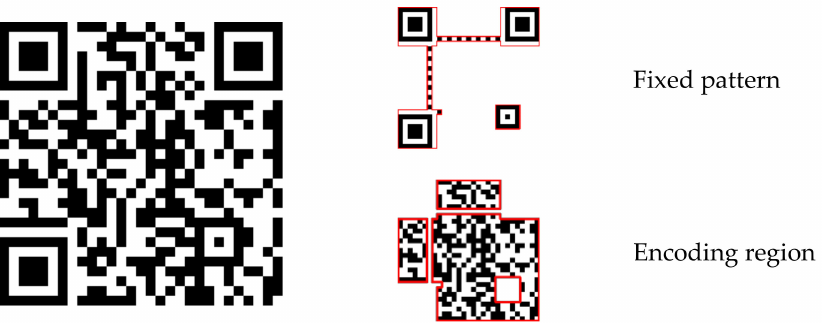
Figure 3. QR code